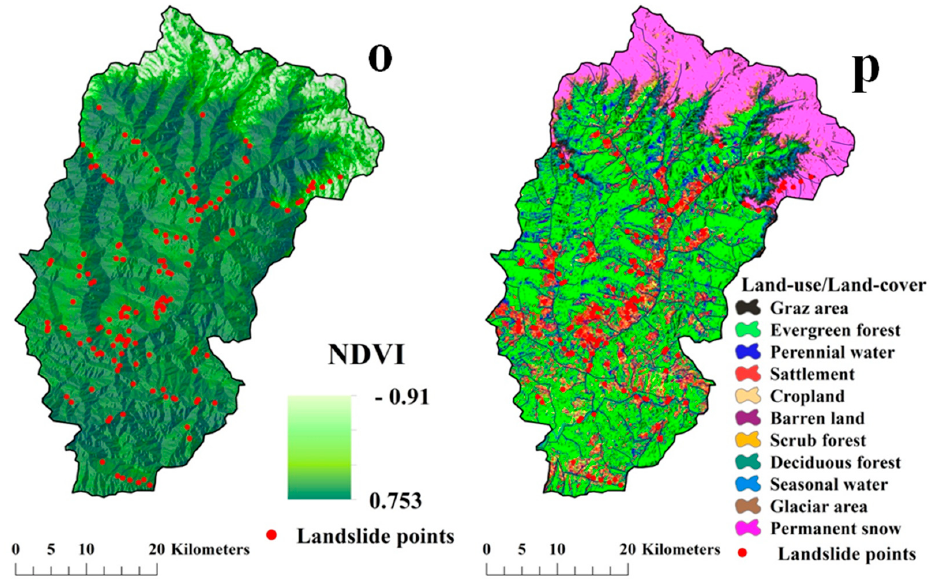
Figure 4. Landslide conditioning factors: ( a ) elevation, ( b ) slope steepness, ( c ) slope aspect, ( d ) curvature, ( e ) stream power index, ( f ) rainfall, ( g ) drainage density, ( h ) topographical wetness index, ( i ) soil depth, ( j ) soil texture, ( k ) distance to lineaments, ( l ) geology, ( m ) seismic zone, ( n ) road density, ( o ) NDVI, and ( p ) land use/land cover (LU/LC). Table 2. Earthquake zonation based on Medvedev–Sponheuer–Karnik (MSK) scale.